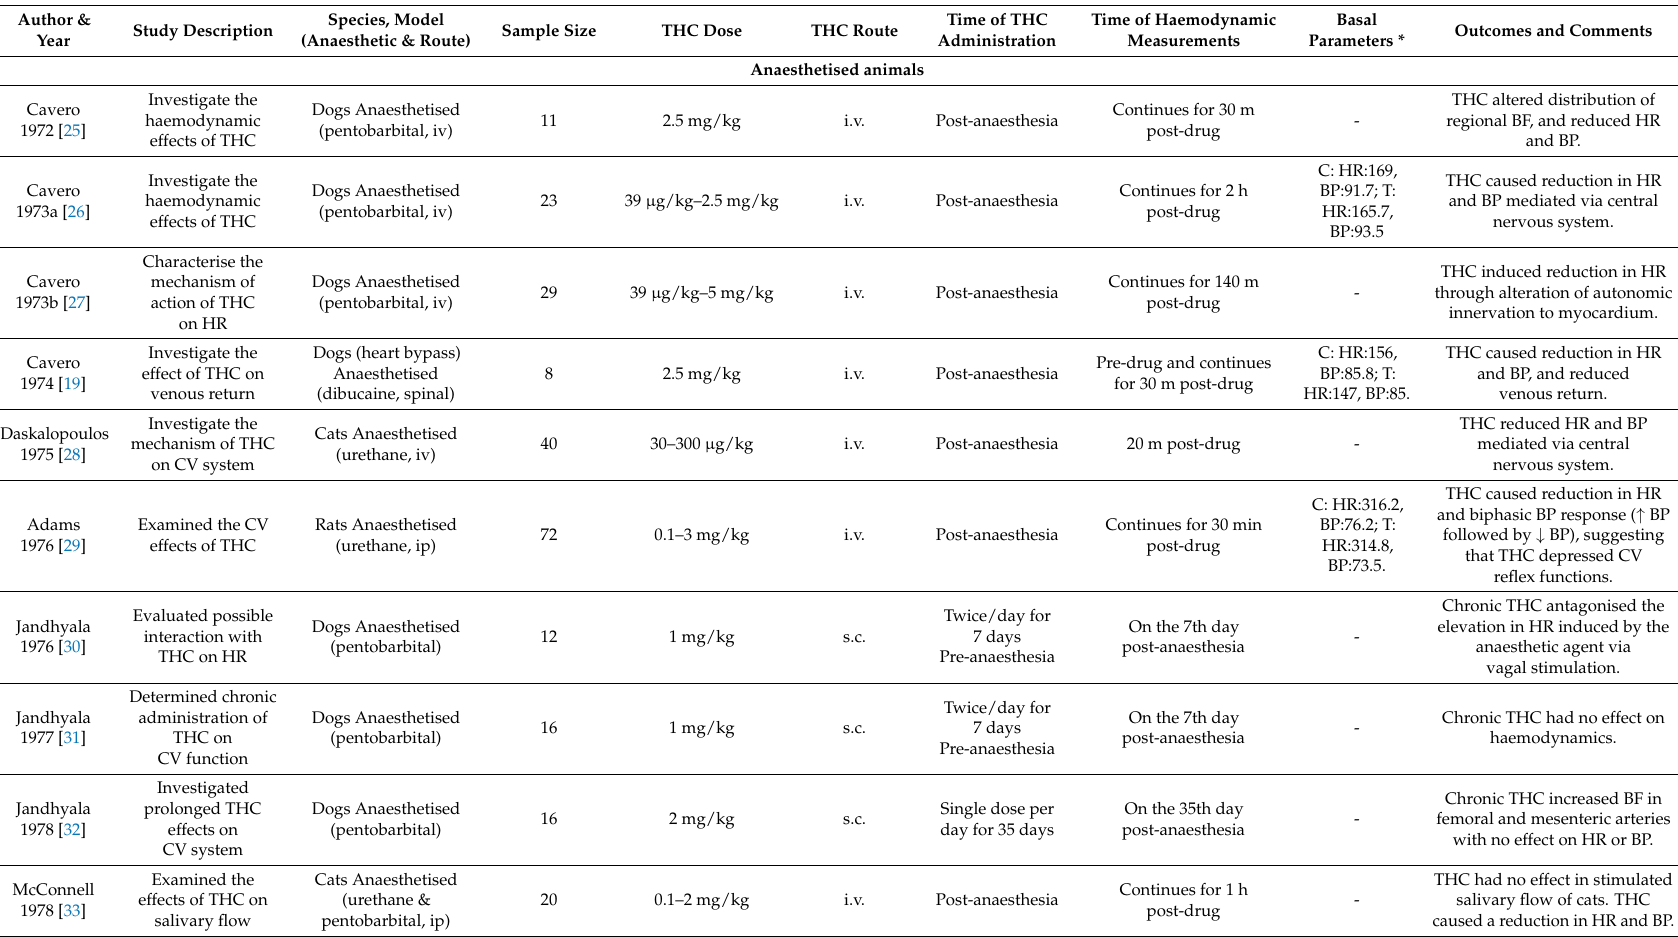
Table 1. Summary of the included studies divided according to the experimental